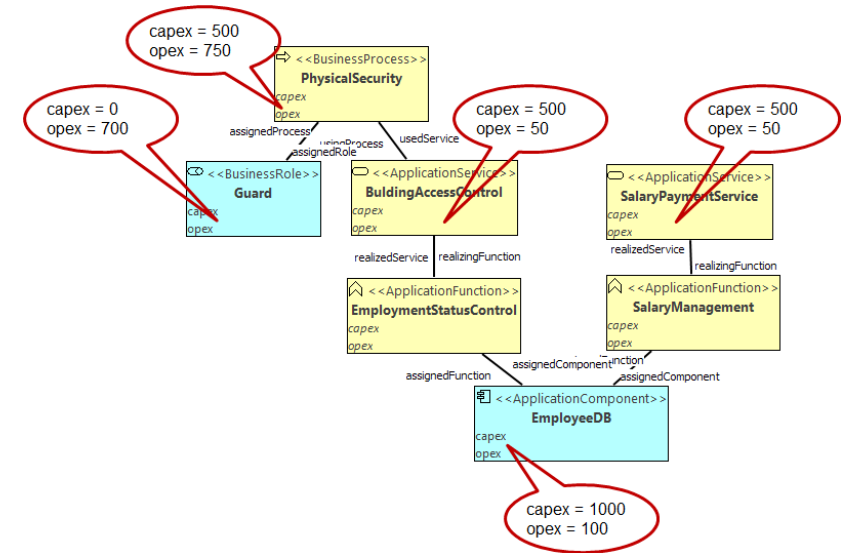
Figure 2. A simple MAPL cost model